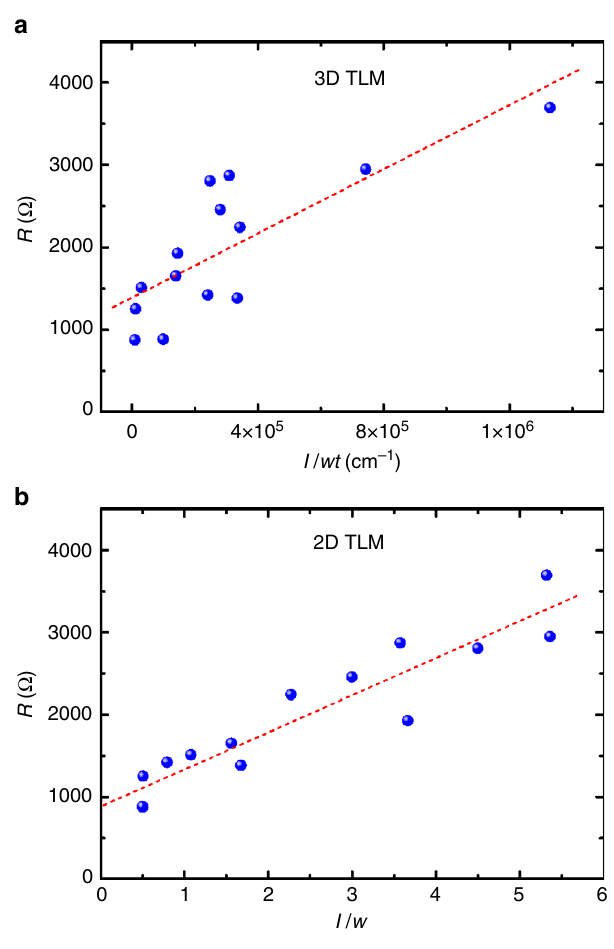
Fig. 4 Analysis of the transfer length method (TLM) for MoS 2 nano fl ake devices. a 3D TLM plot and b 2D TLM plot for MoS 2 nano fl akes. The red dashed lines are the fi tting lines for the resistance ( R ) versus l / wt curve in a and R versus l / w curve in b